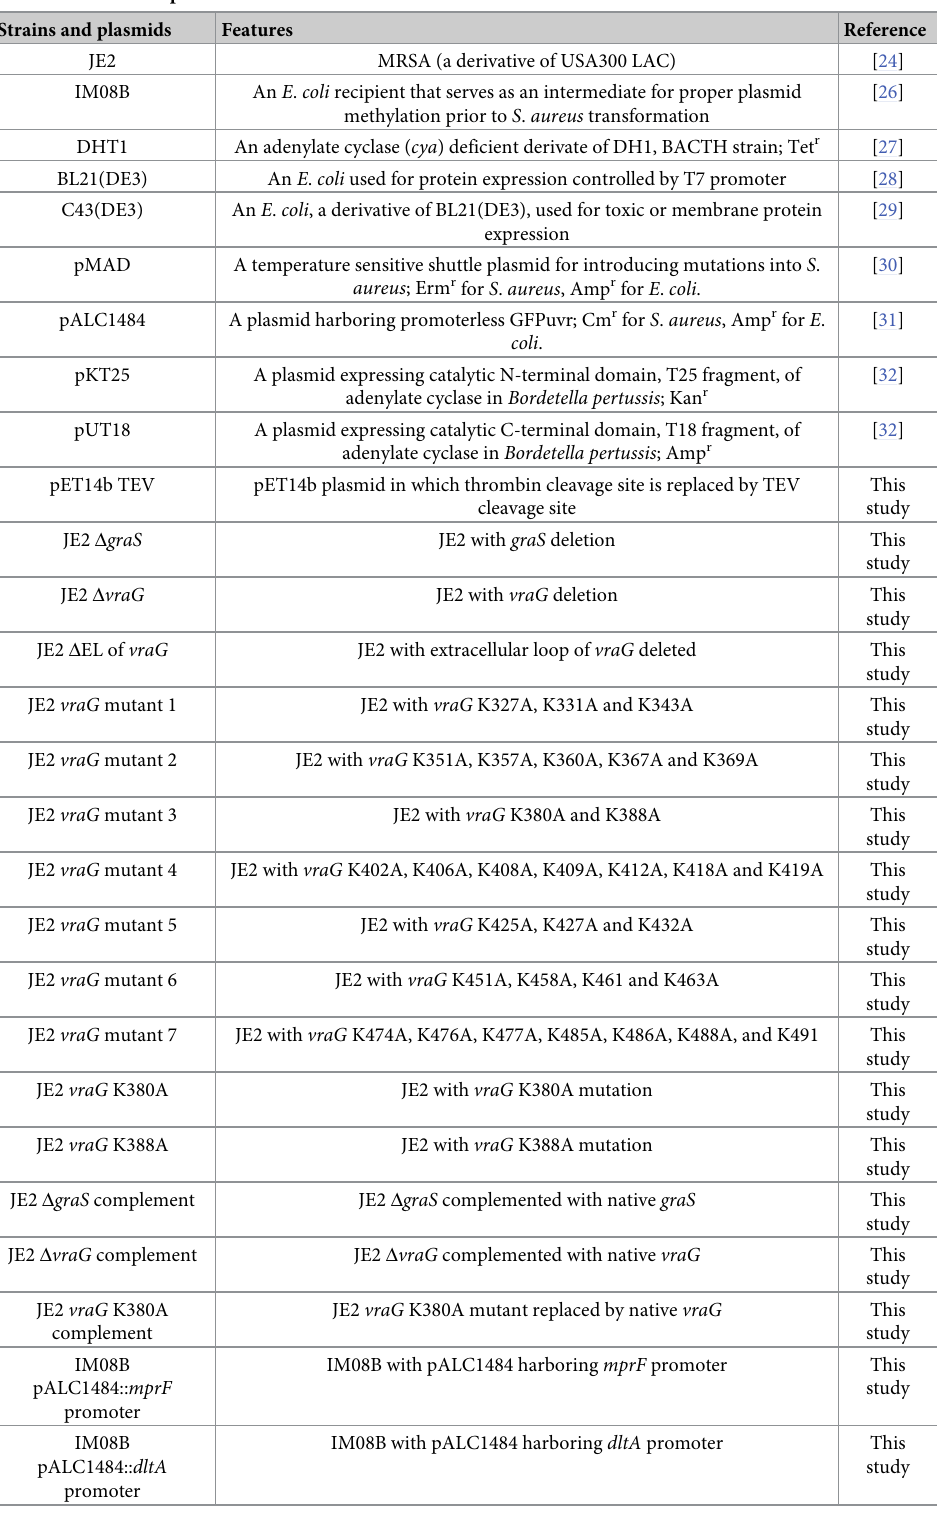
Table 1. Strains and plasmids. Strains and